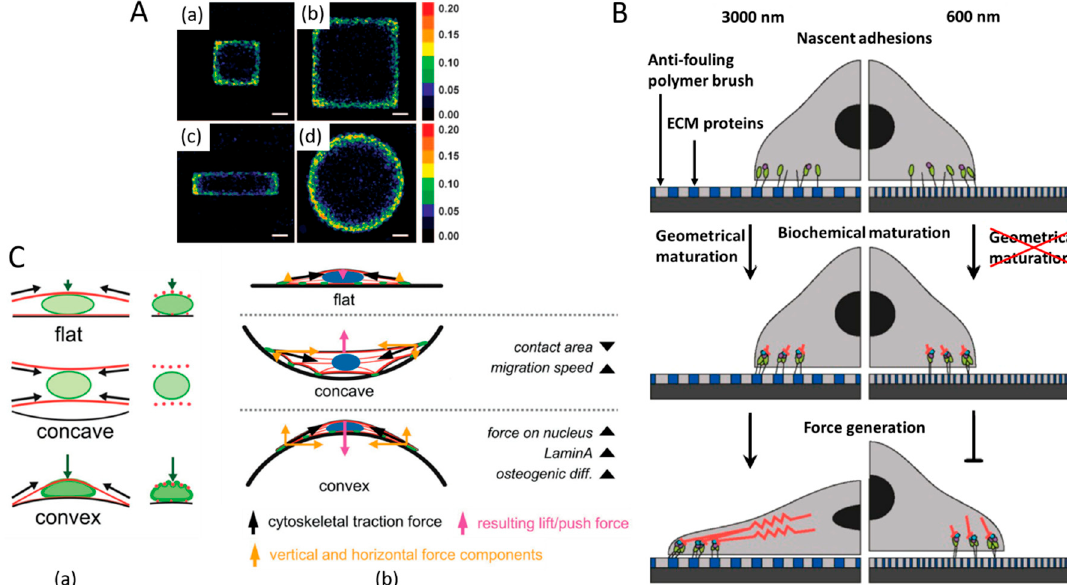
Figure 2. The e ff ects of substrate geometry on cells. ( A ) The patterns of forces exerted by the cells responding to the edges and boundaries of di ff erent substrates. (a) Colorimetric stacked images of cell proliferation in a small (250 µ m edge) square, (b) large (500 µ m edge) square, (c) small (125 × 500 µ m) rectangular, and (d) large (564 µ m diameter) circular islands [37]. “Reprinted with permission from ref. [37]. Copyright 2005, National Academy of Sciences” ( B ) A model of geometrical, biochemical,